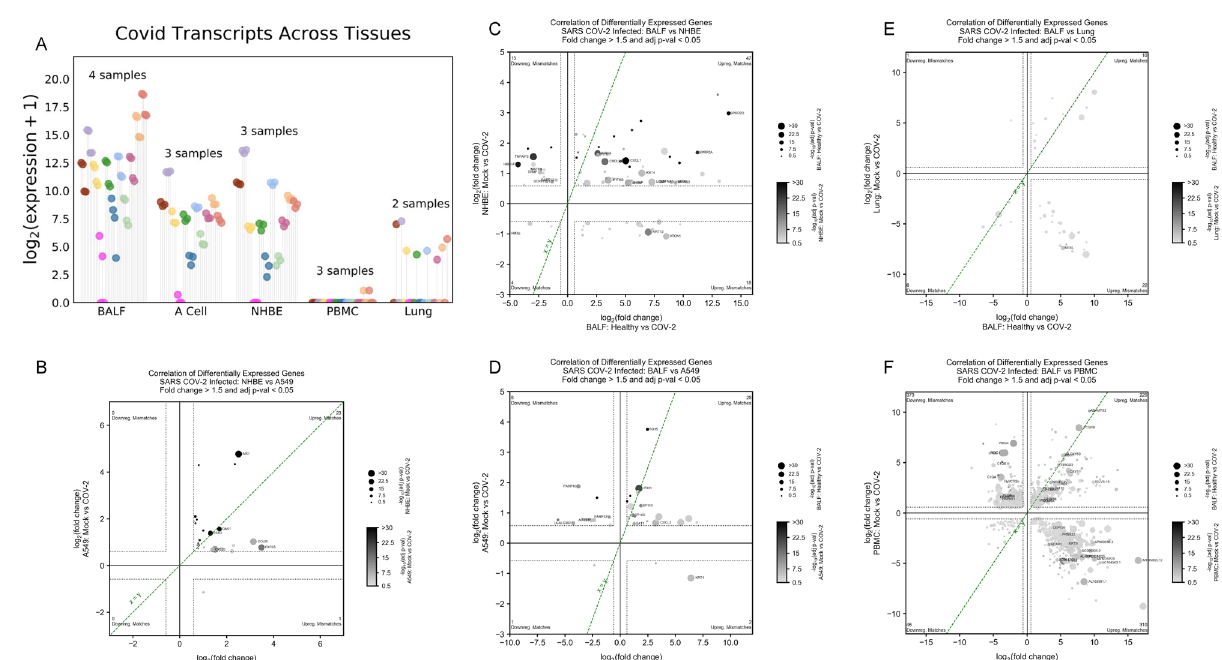
Figure 2. ( A ) dRAP is sensitive enough to detect subtle differences in SARS-CoV-2 transcripts quantities resulting in differential expression within the SARS-CoV-2 transcriptome. SARS-CoV-2 expression is also shown to be highly dependent on the system being studied. Patient BALF samples show high amounts of SARS-CoV-2, while PBMC and Lung patient samples display low or no SARS-CoV-2. ( B – F ) Log2 fold change comparison between differentially expressed genes in infected samples against non-infected samples shows that the tissue specificity of SARS-CoV-2 extends to the degree of concordance observed in the human transcriptome. Statistically significant concordance was observed between NHBE and A549 cell lines ( p < 1e−5) (B) and BALF patient samples with NHBE ( p < 0.05) ( C ) and A549 ( p < 0.01) ( E ) cell lines using the chisquare test. However, there was no concordance observed in BALF versus Lung ( p = 0.26) ( D ) and a significant discordance versus PBMC ( p < 1e−38) ( F ) patient samples. This suggests that the lack of SARS-CoV-2 expression observed in Lung and PBMC samples is also associated with significantly altered human expression, making these tissue types not ideal for learning SARS-CoV-2